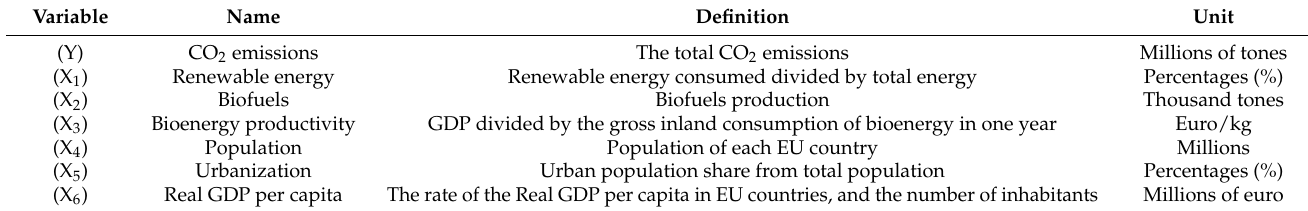
Table 2. A description of the variables of the econometric